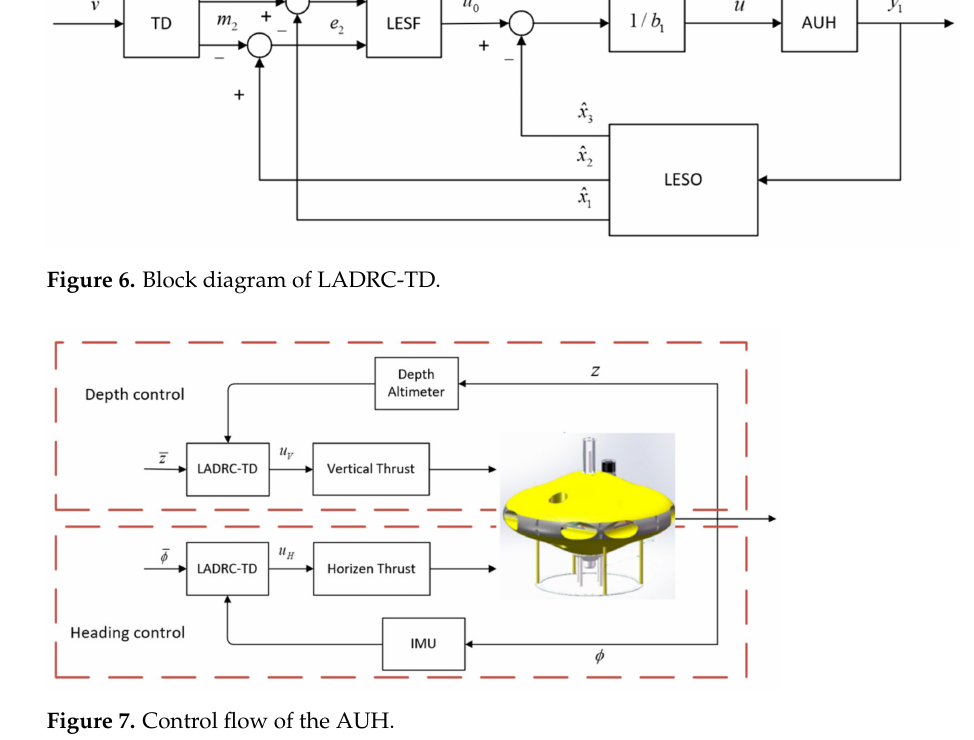
Figure 7. Control flow of the